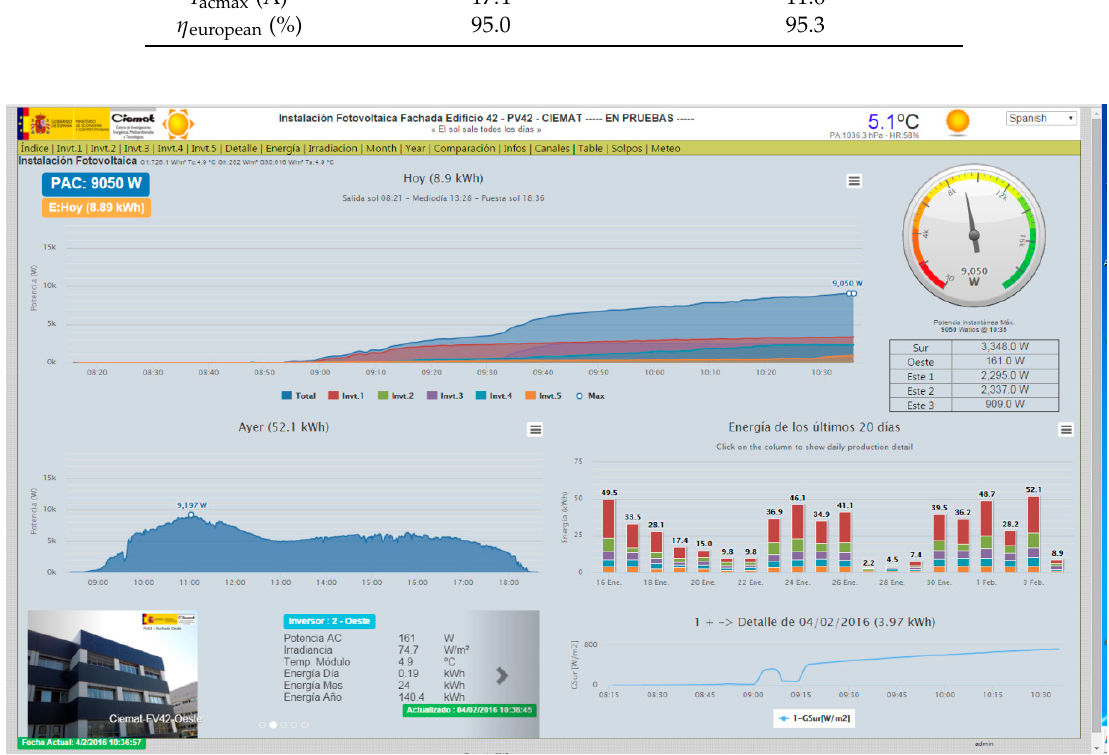
Figure 6. Real-time monitoring of the electrical variables of the grid-connected photovoltaic installation.